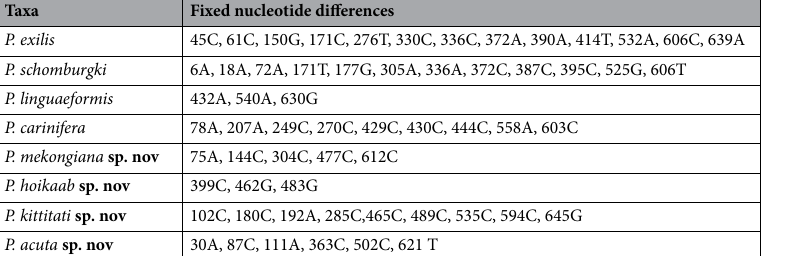
Taxa Fixed nucleotide